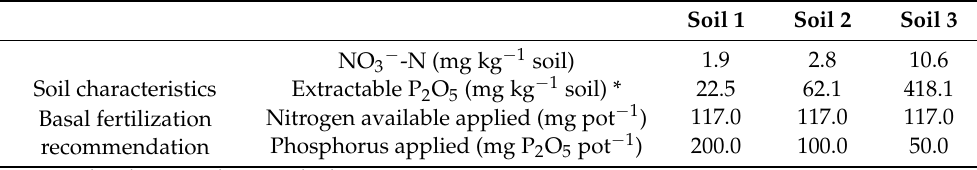
Table 2. Soil initial characteristics and the respective basal fertilization